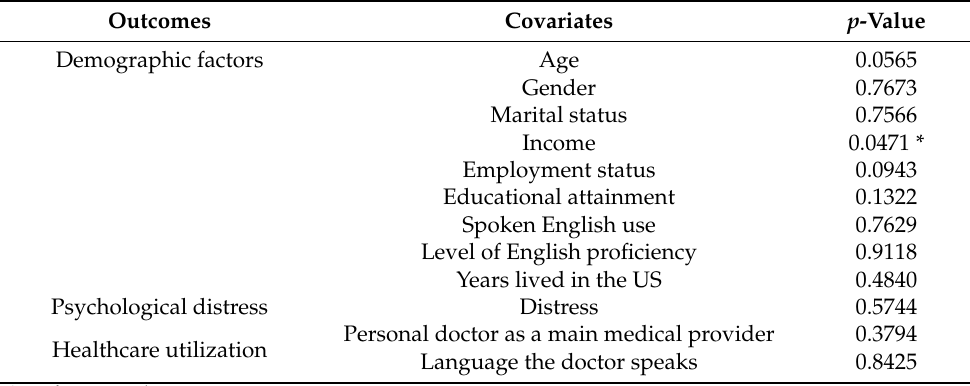
Table 3. Weighted logistic regressions with current smoking as the